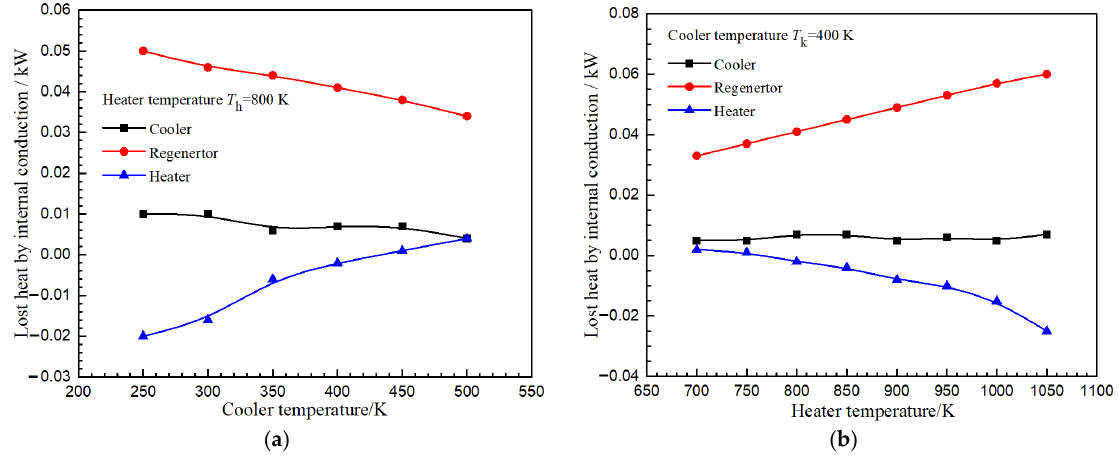
Figure 14. The effect on heat loss by internal conduction: ( a ) effect of cooler temperature, ( b ) effect of heater temperature.